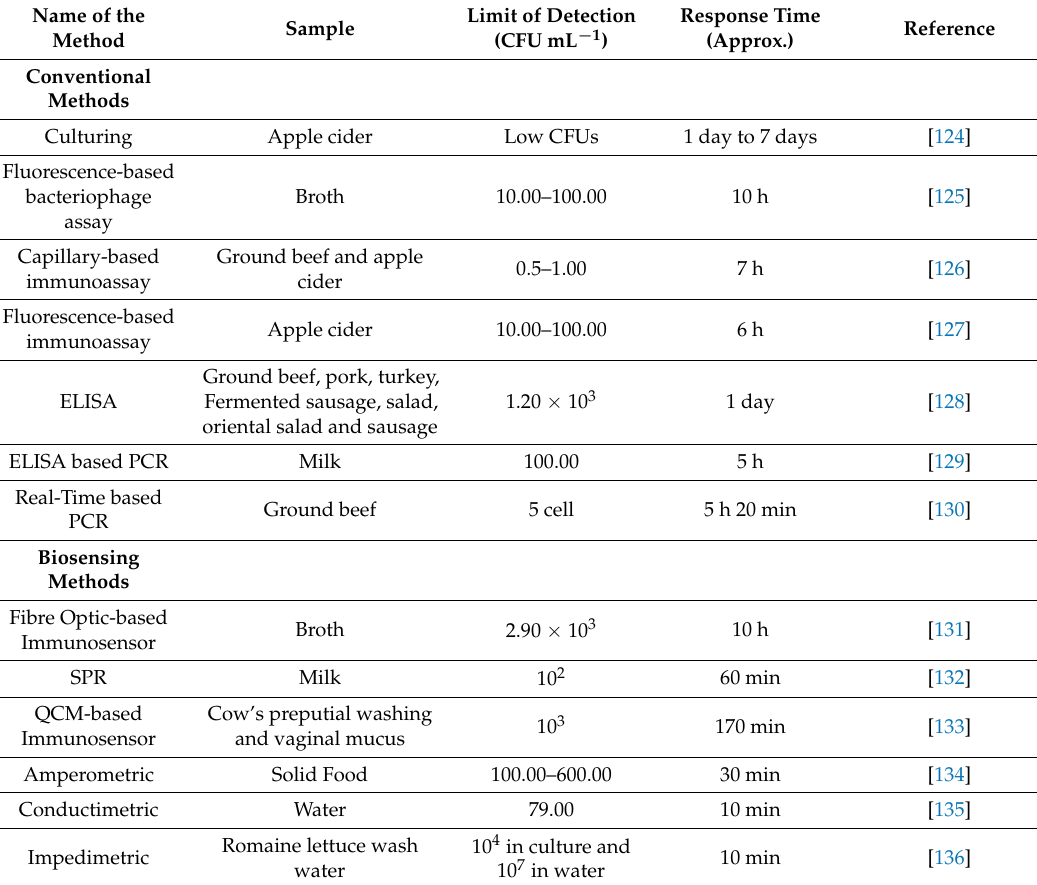
Table 2. Existing E. coli method of detection, sampling, and their response